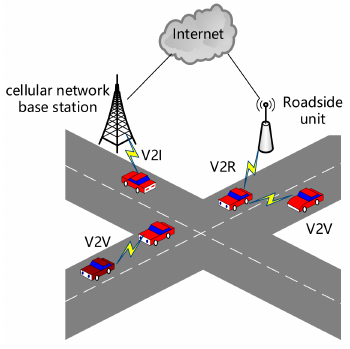
Figure 4. Structure diagram of